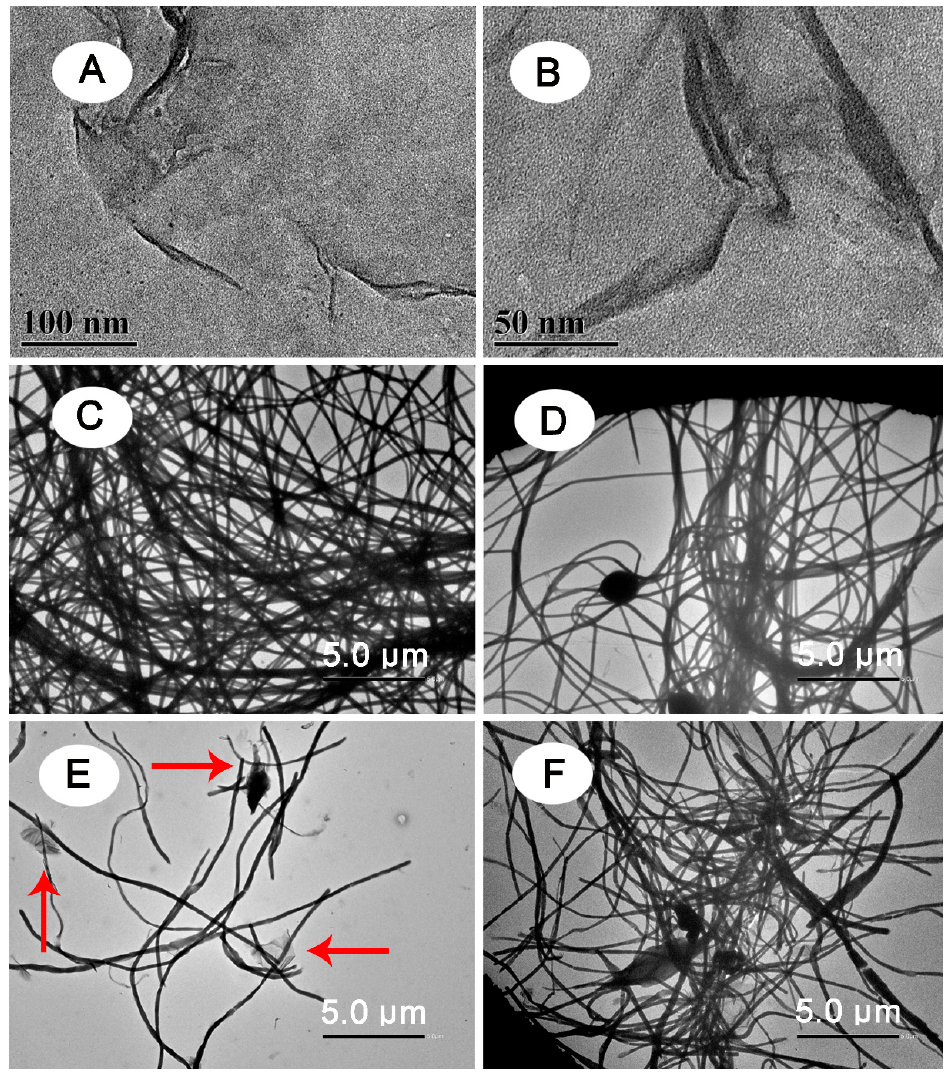
Figure 3. TEM image of ( A , B ) GO, ( C ) PAN, ( D ) PAN/DCDMH, ( E ) PAN/GO, and ( F ) PAN/GO/DCDMH. To acquire compositional information, the chemical compositions corresponding to the morphology of the as-electrospun products were tested using the SEM-EDX tech- nique. Figure 4 and Table 2 present (A1–D1) SEM images and the corresponding (A2–D2) EDX spectra of (A) PAN, (B) PAN/DCDMH, (C) PAN/GO, and (D) the PAN/GO/DCDMH fibrous membrane. The EDX spectra were examined at selected regions on the SEM im- ages. Pristine PAN (Figure 4(A2)) displayed two intensive peaks assigned to the C and N signals, suggesting that the PAN support consisted mainly of carbon and nitrogen. Unlike pristine PAN, PAN/DCDMH (Figure 4(B2)) presented two additional peaks, attributed to